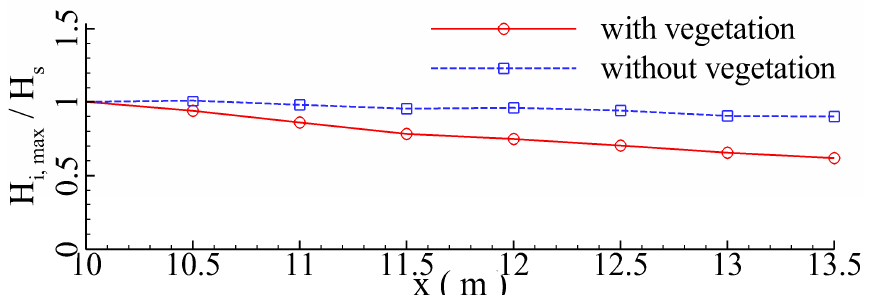
Figure 8. Water elevations at front and rear sides of the emergent vegetation patch.